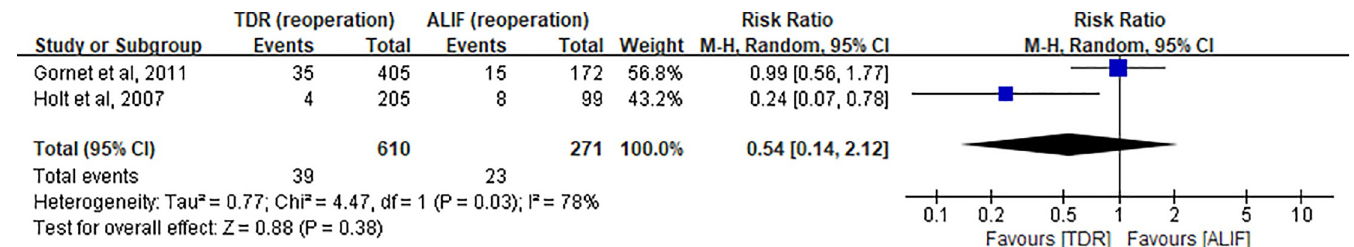
Fig 9. Forest plot for the number of re-operation. df = degrees of freedom, and M-H = Mantel-Haenszel.